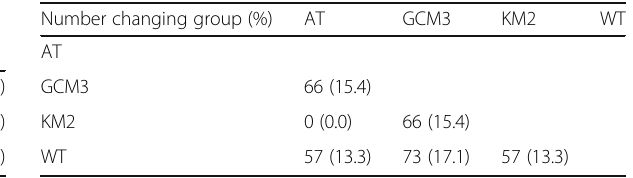
Table 6 Number of patients in each risk stratification group for each single prognostic model and prognostic score range Number of patients Low-risk Intermediate-risk High-risk in risk group (prognostic range)